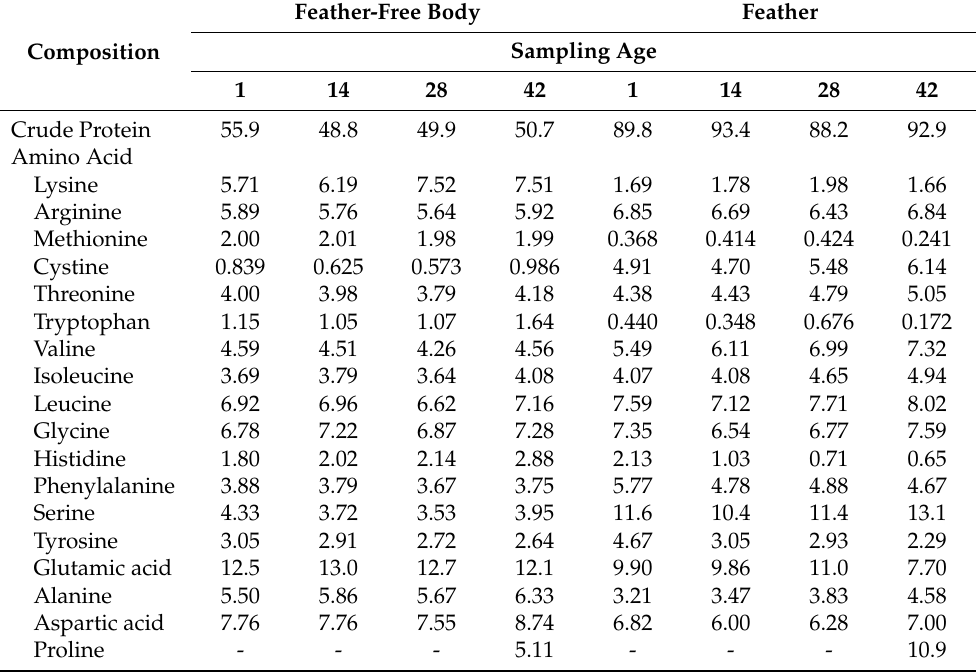
Table 3. Protein (% of dry matter) and amino acid content (mg of amino acid/100 g of protein) of broiler chickens sampled at different